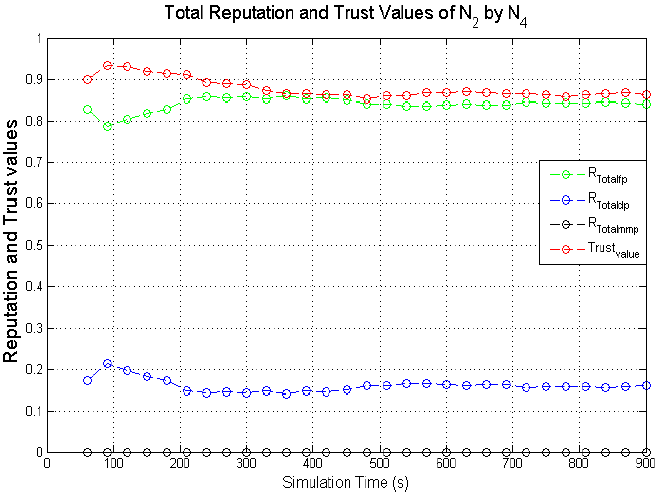
Figure 15. Nodes N 2 and N 4 are both benevolent and honest.